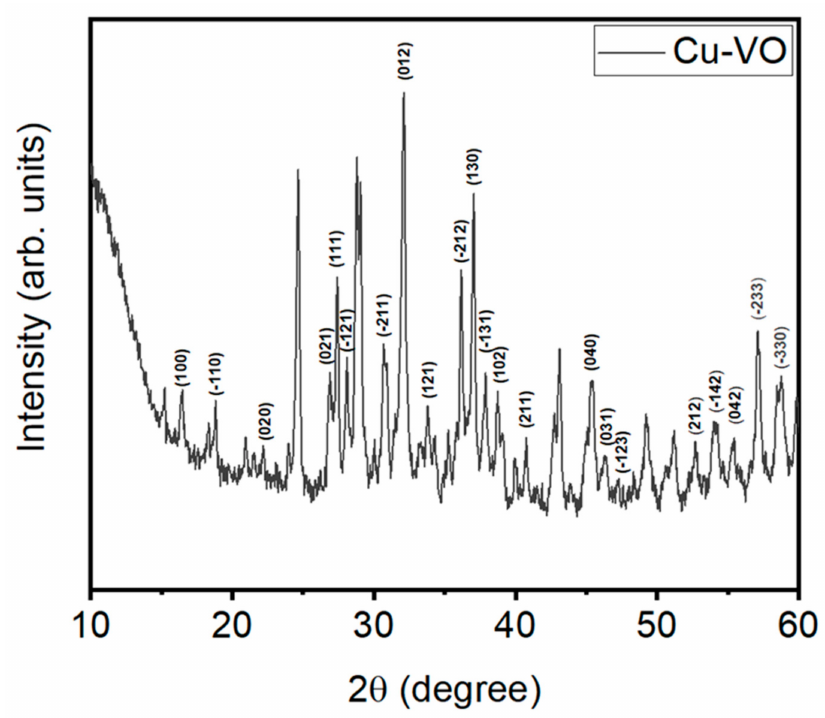
Figure 3. X-ray diffraction patterns of Cu-VO.